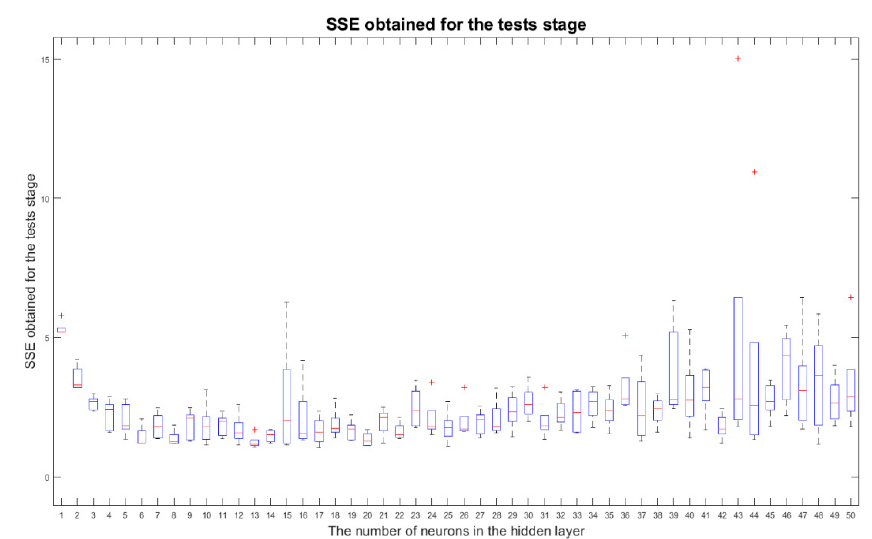
Figure 7. Summed square of residuals ( SSE ) obtained for the neural network structure with a certain number of neurons in a hidden layer—results for the tests on stage.